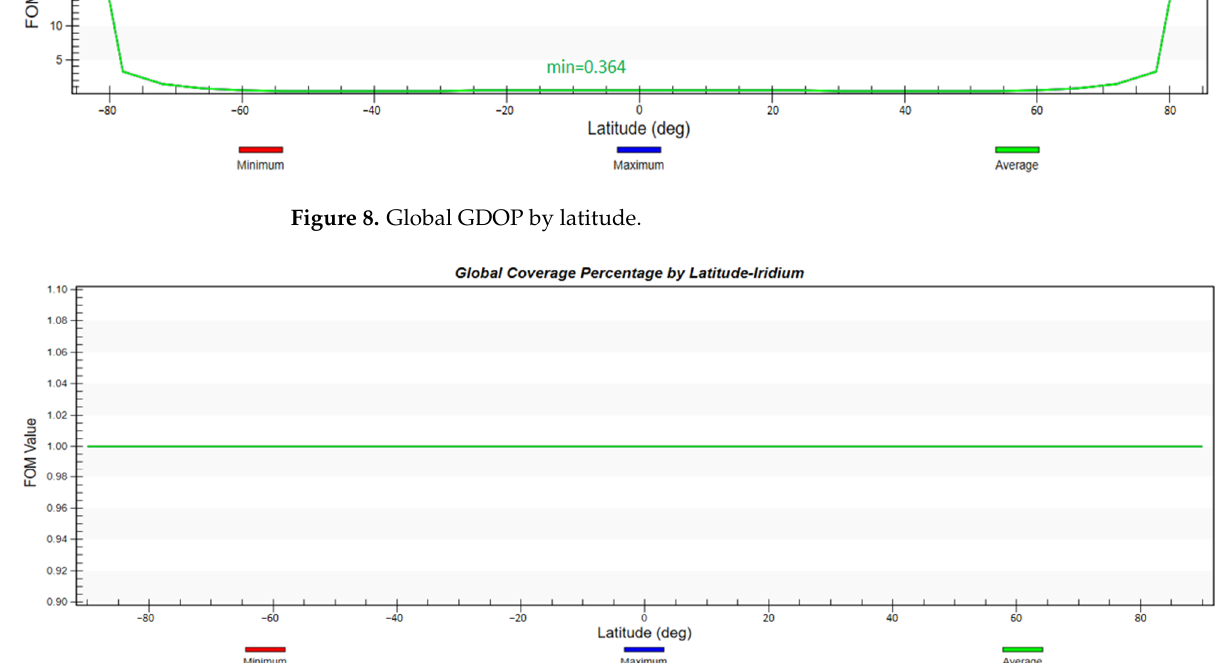
Figure 8. Global GDOP by latitude.